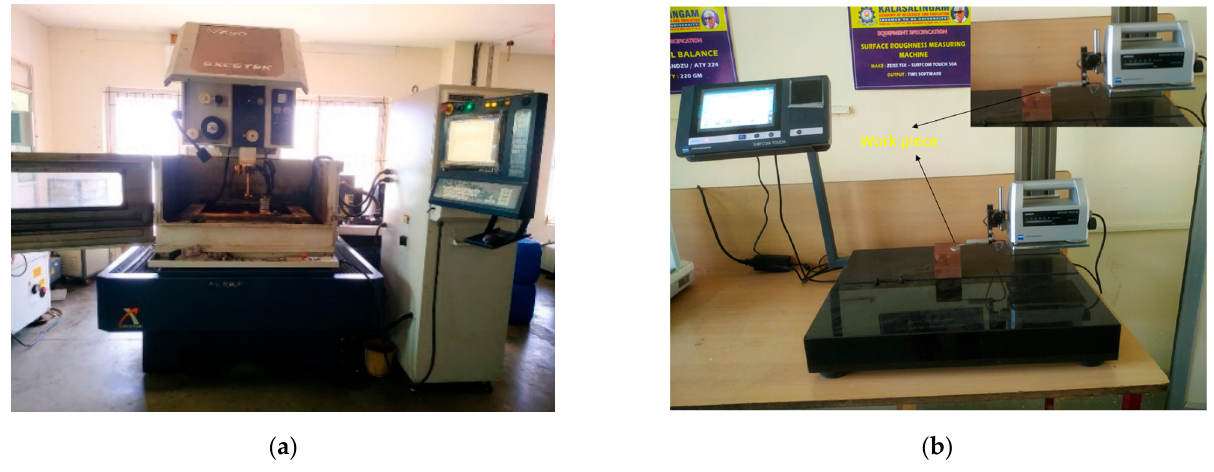
Figure 1. ( a ) Wire EDM experimental setup; ( b ) surface roughness measuring setup.